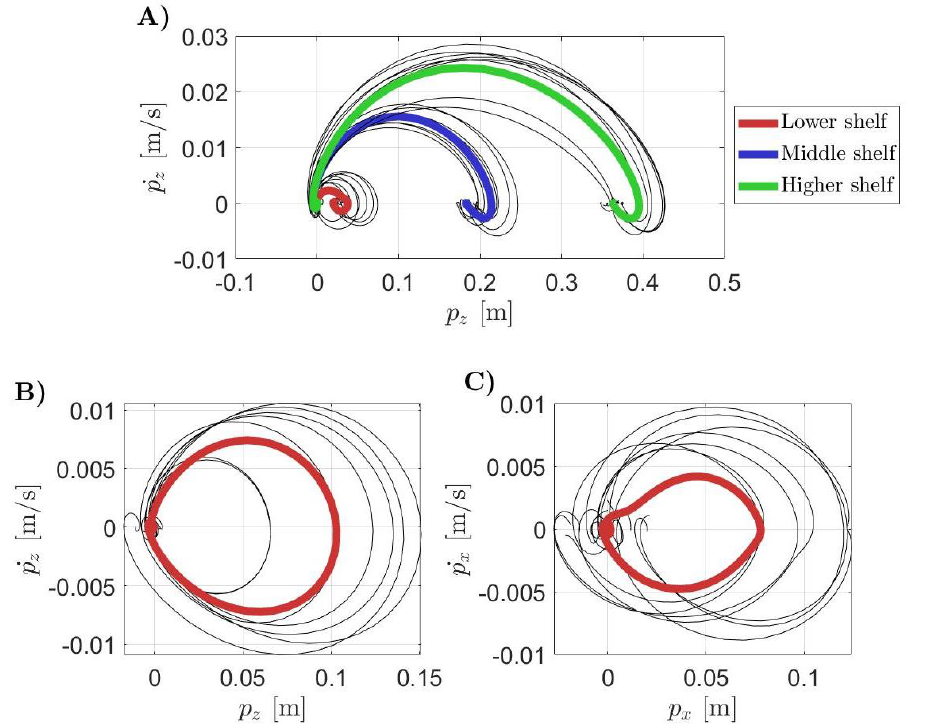
Figure 5. Phase plane plots for the working gestures of the WGD. The plot ( A ) is referred at the handling goods task: the higher the shelf, the higher the displacement from the origin. Plots ( B , C ) are about the rhythmic tasks, i.e., hammering and screwing. In particular, the dynamic evolution of the hammering sub-task is reported on the left while there is the screwing on the right. The coloured and gray lines represent the mean phase plane trajectory and the single recorded trials,